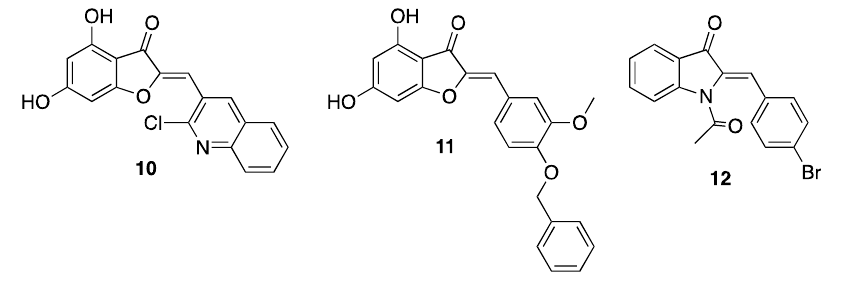
Figure 3. Representative synthetic antibacterial aurones.